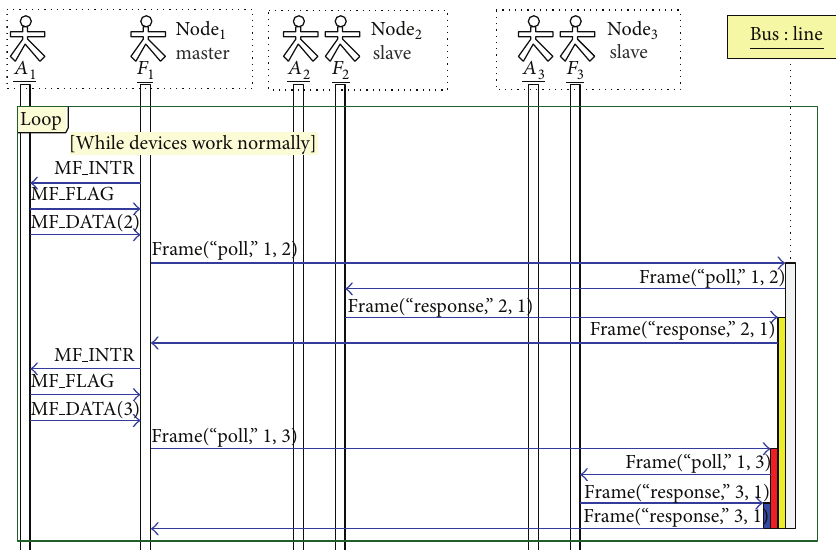
Figure 6: Message chart of polling process.